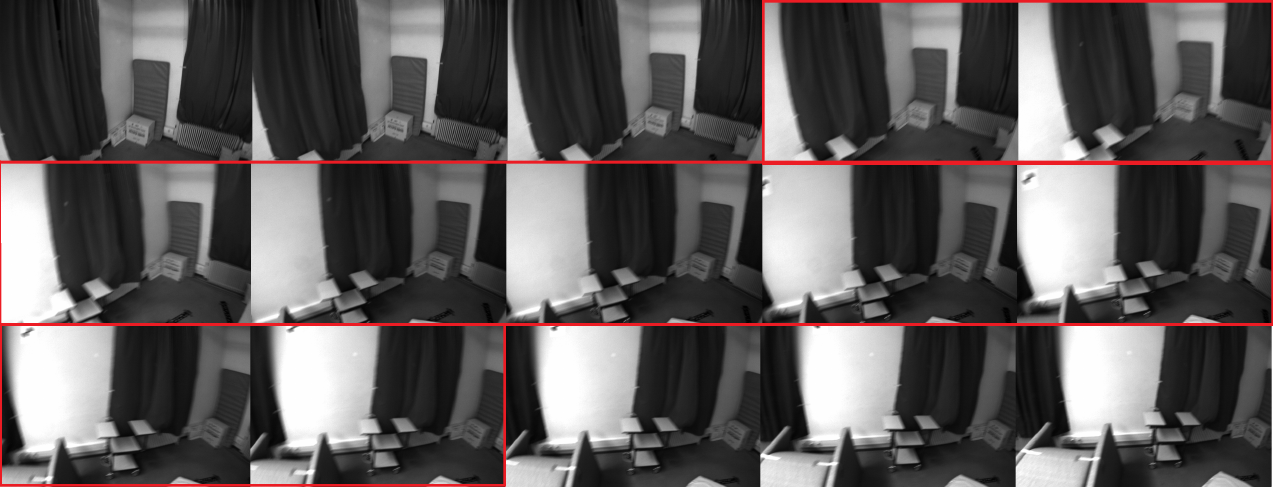
Figure 10. Motion blur in V203 sequences. The image in the red rectangle is the blurred